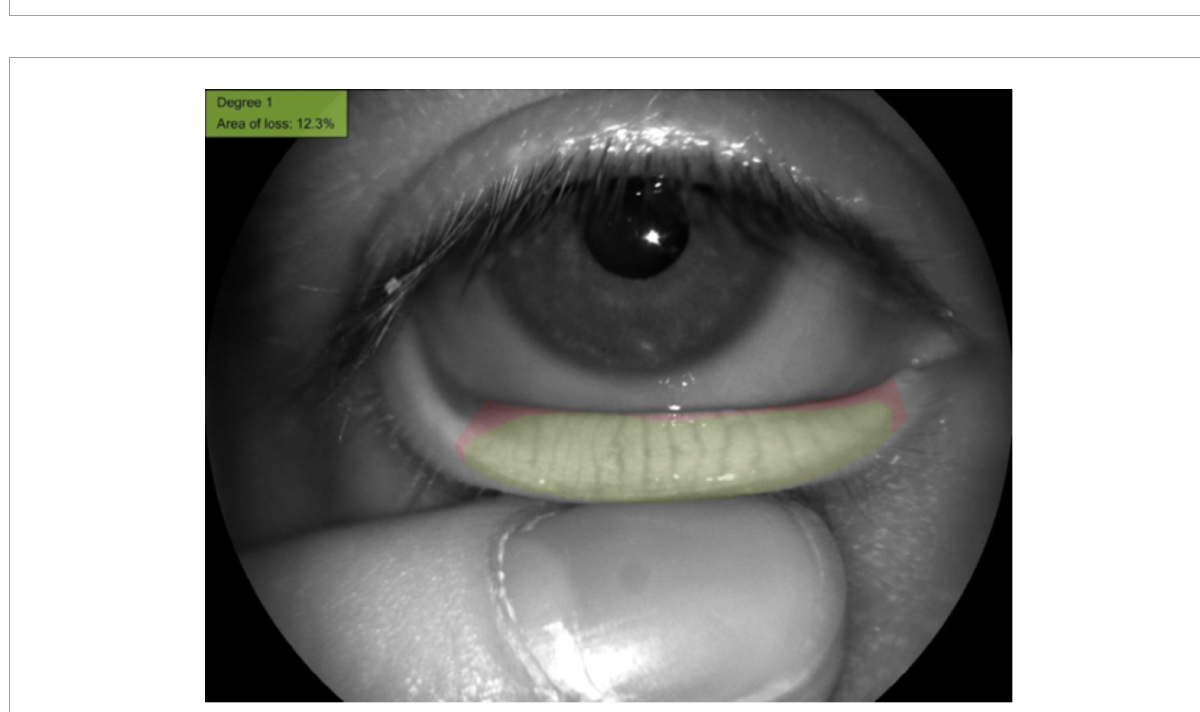
FIGURE3 The meibomian gland loss area measured with the Keratograph 5M